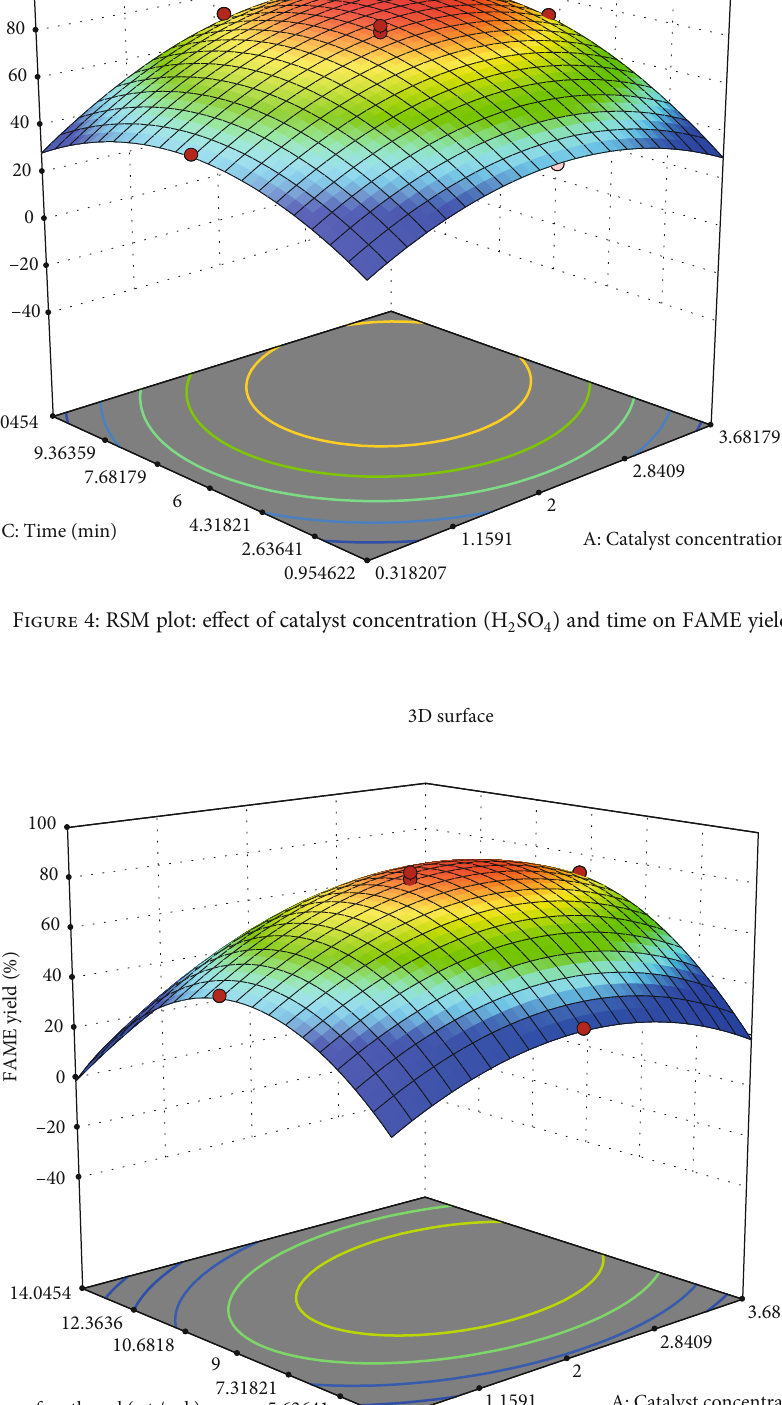
SO ) and volume of methanol ( CH 2 4